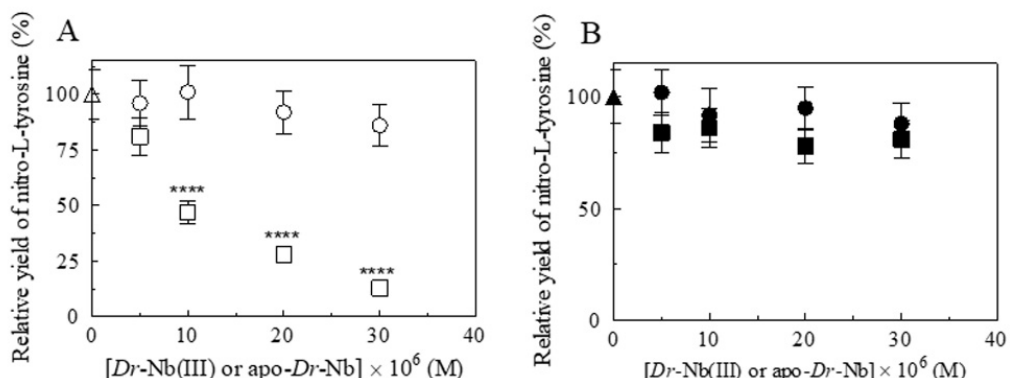
Figure 6. Effect of Dr -Nb on L-tyrosine nitrosylation induced from peroxynitrite, at pH 7.0 and 22.0 ◦ C. ( A ) Dependence of the nitro-L-tyrosine yield on the Dr -Nb(III) (open squares) and apo- Dr -Nb (open circles) concentration in the absence of CO 2 (One-way ANOVA: open squares, **** p < 0.0001, 0 M versus 10 × 10 − 6 M, 20 × 10 − 6 M, and 30 × 10 − 6 M). ( B ) Dependence of the nitro-L-tyrosine yield on the Dr -Nb(III) (filled squares) and apo- Dr -Nb (filled circles) concentration in the presence of CO 2 . The symbols on the y -axis (open and filled triangle) indicate the nitro-L-tyrosine yield in the absence and presence of CO 2 , respectively. The L-tyrosine concentration was 1.0 × 10 − 4 M. The peroxynitrite concentration was 2.0 × 10 − 4 M. Where not shown, the standard deviation is smaller than the symbol. Table 4. Percentage of NO 3 − and NO 2 − obtained from peroxynitrite isomerization at pH 7.0 and at 22.0 ◦ C a .